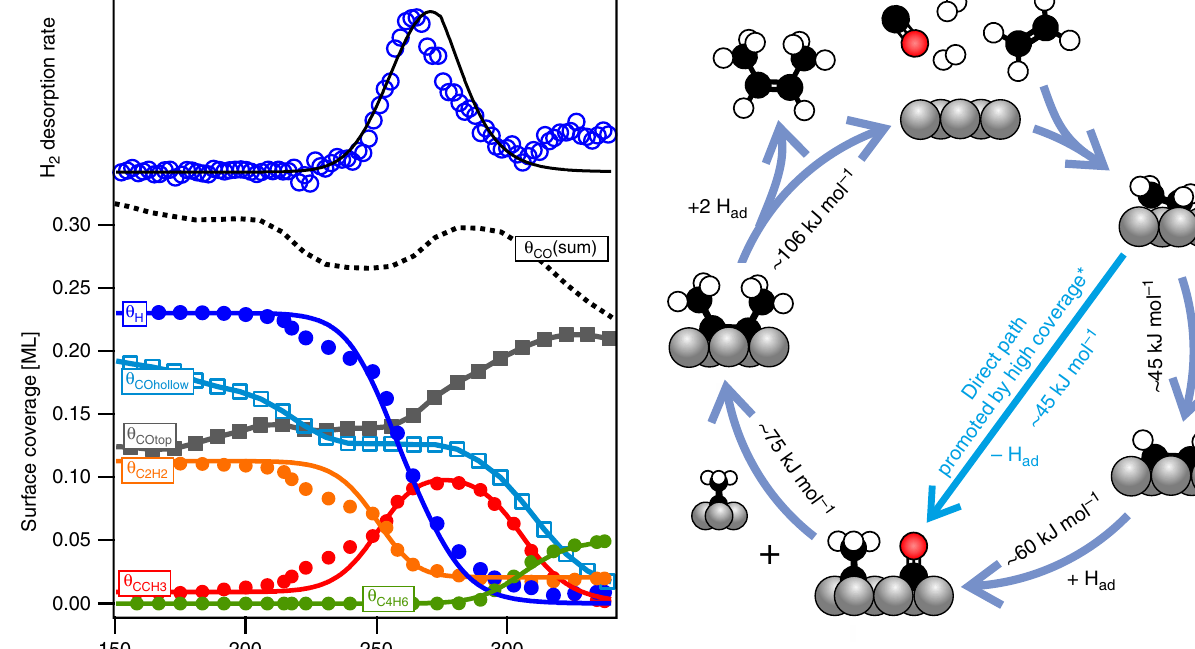
Fig. 7 Proposed catalytic cycle of CO-induced ethylene dimerization. The proposal is based on the experimental fi ndings on Co(0001) presented here and in ref. 21*